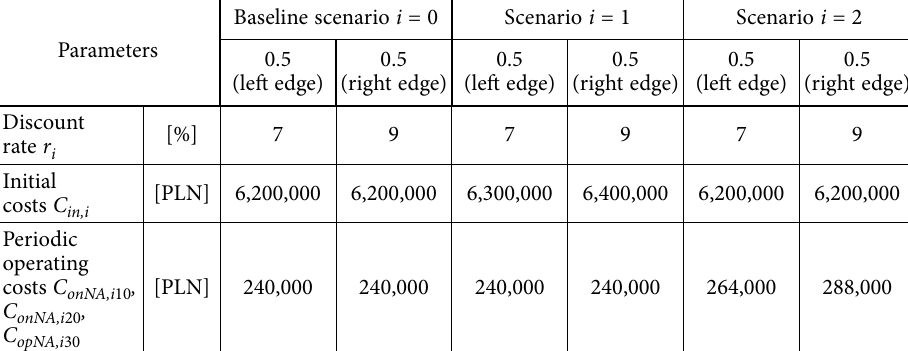
Table 7. Values of selected input parameters in section α = 0.5